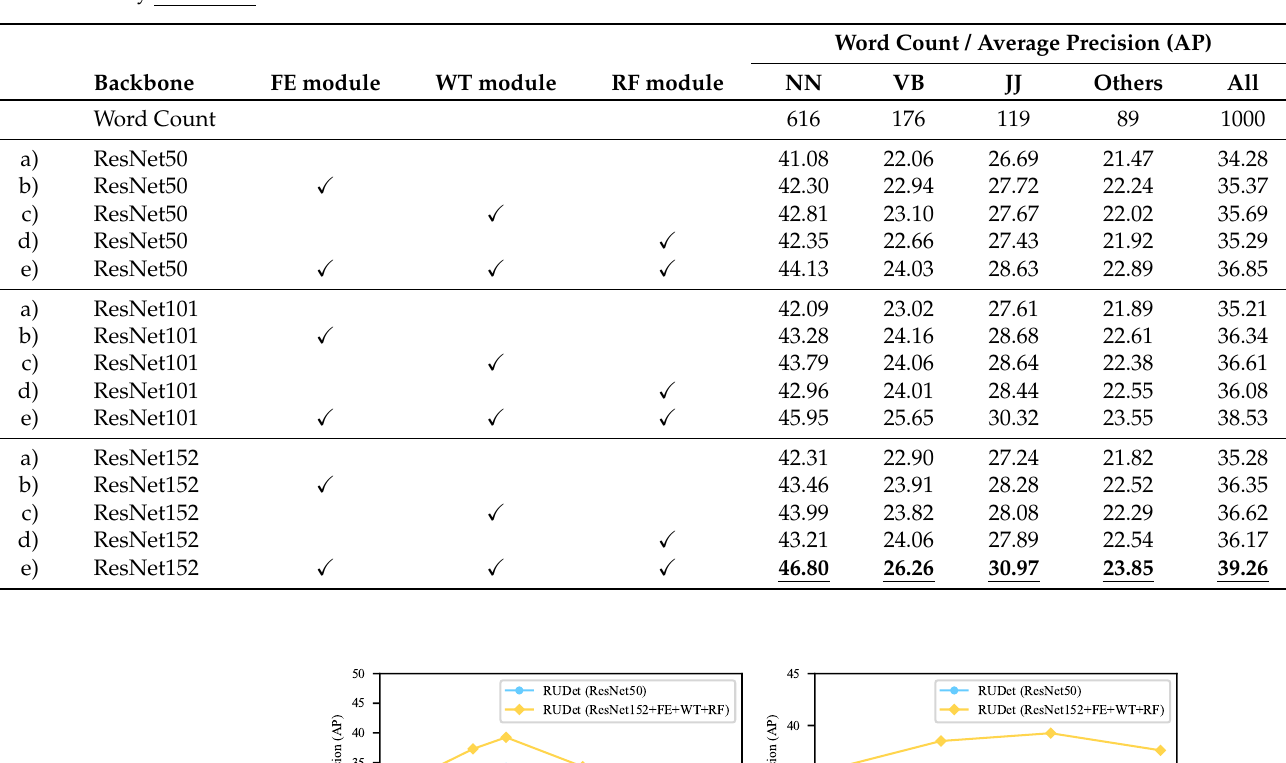
Table 1. The comparison among the different versions of the proposed RUDet. In each column, the highest values are marked by underline .